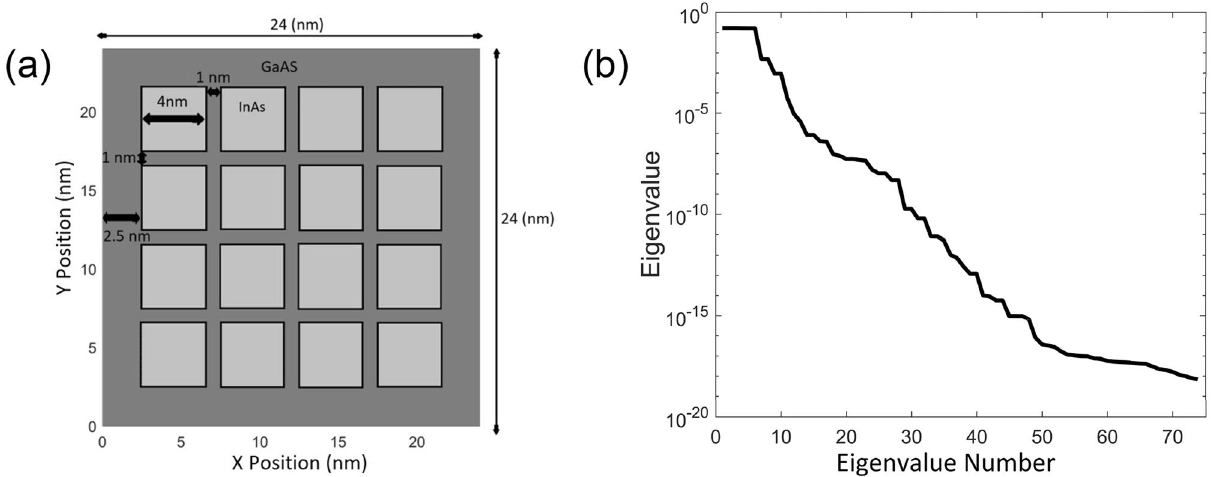
Figure 1. ( a ) Underlining GaAs/InAs QD structure for the demonstration of the POD-Galerkin simulation methodology. ( b ) Eigenvalue for the WF data in descending